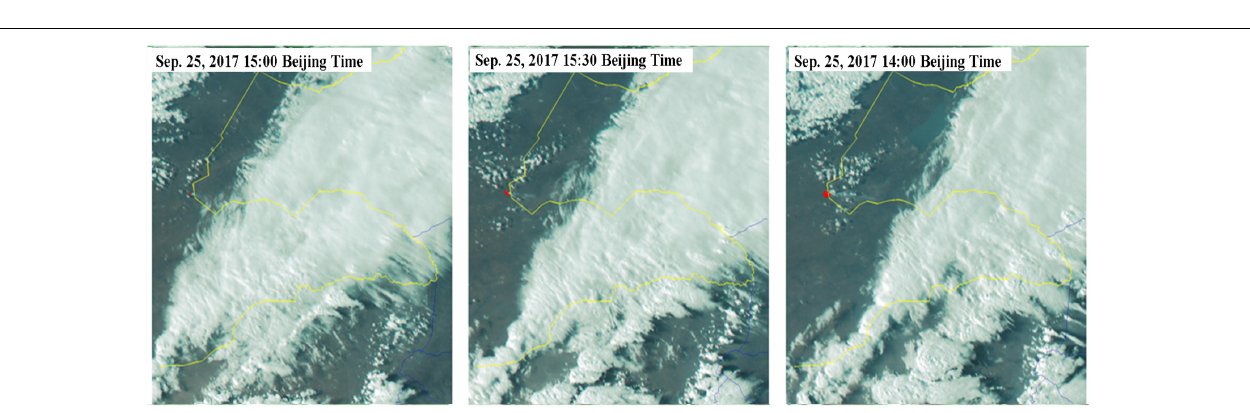
FIGURE 7 | FY-4A/AGRI fire monitoring over Inner Mongolia, China, on 25 September 2017, 15:00–16:00 Beijing Time (2 km resolution).